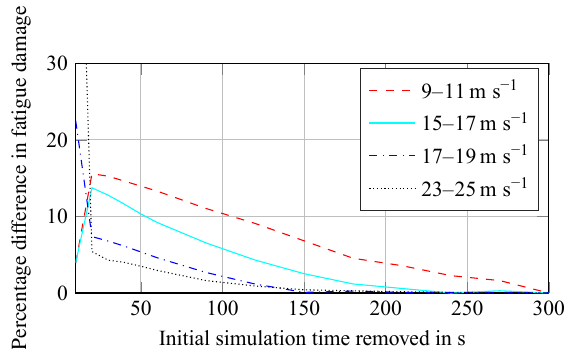
with a monopile substructure for different wind speeds. Percentage difference in the fatigue damage compared to the “converged” value